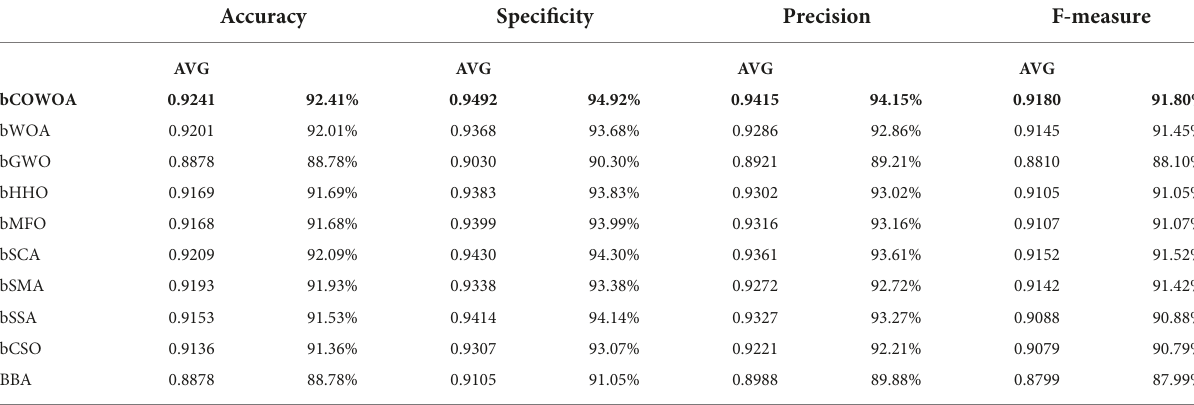
TABLE 21 The average of bCOWOA and well-known binary algorithms. Accuracy